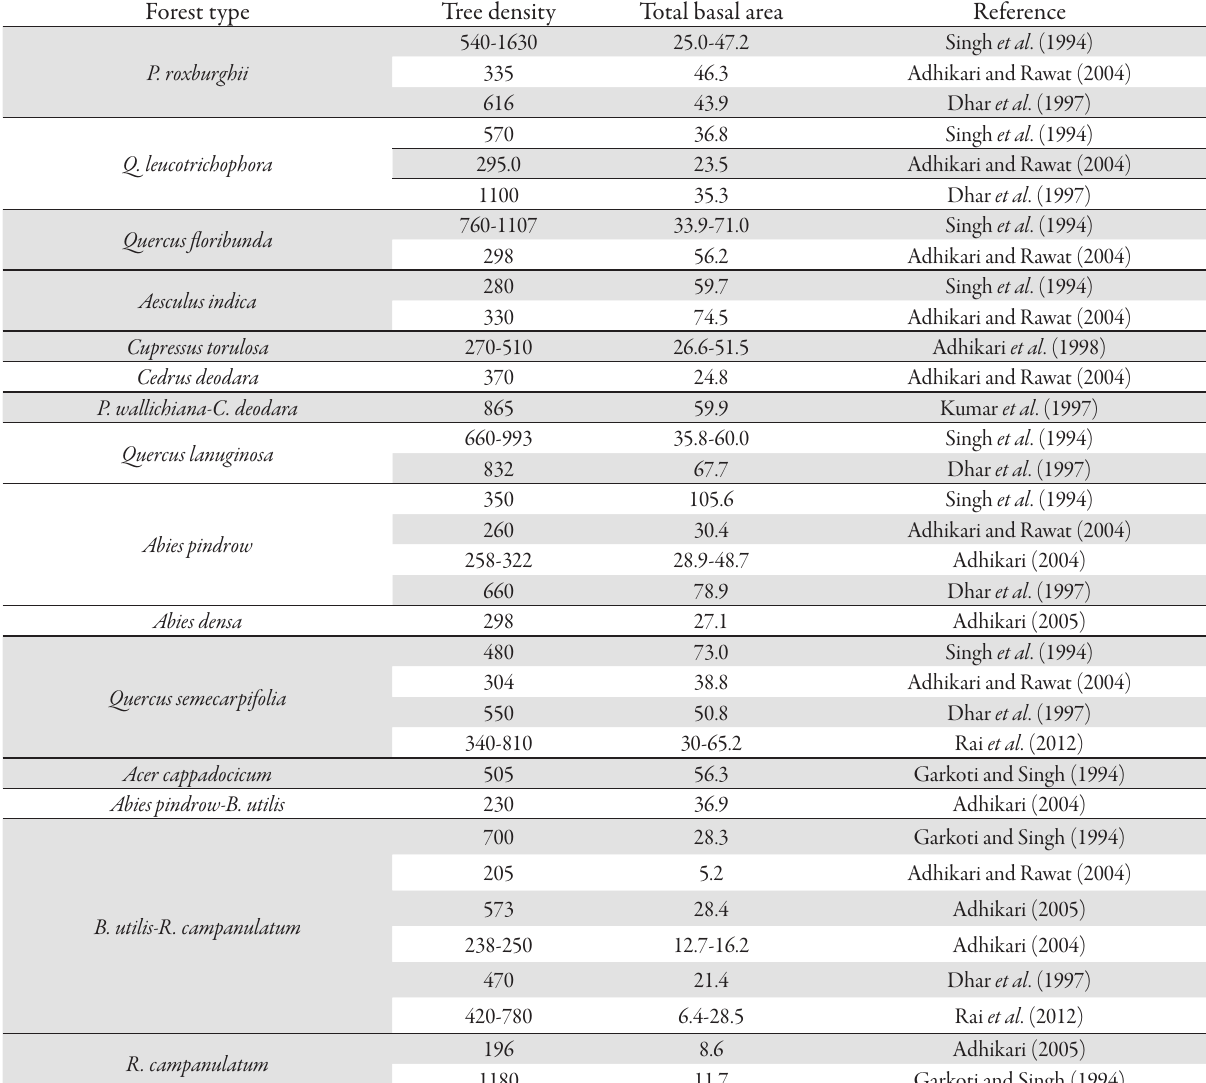
Tab. 4. Comparative account of tree density (tree ha -1 ) and total basal area (m 2 ha -1 ) from different study sites in west